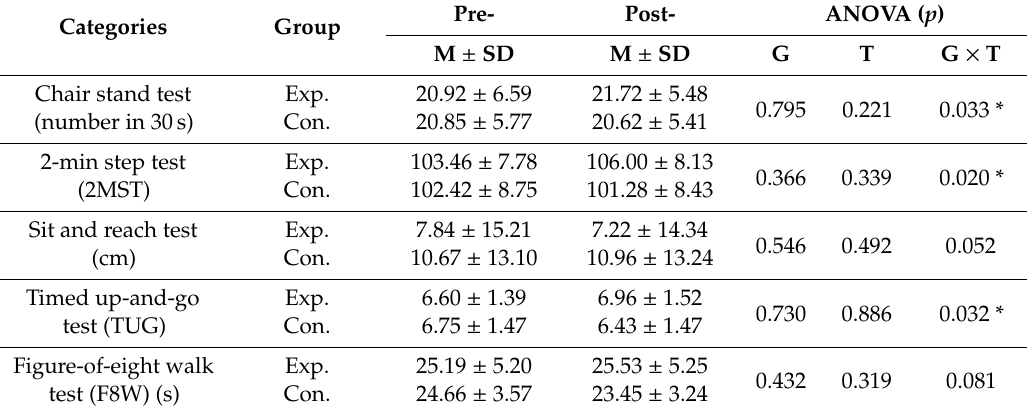
Table 4. E ff ects of augmented-reality-based exercise on muscle parameters, physical performance, and exercise self-e ffi cacy for older adults.